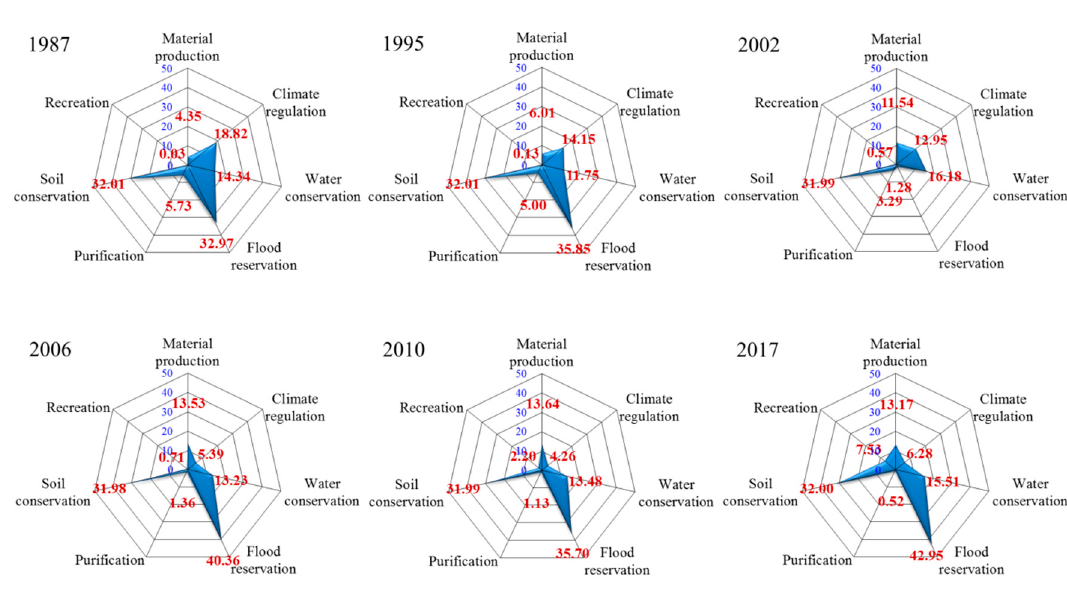
Figure 4. The annual values of each ES from 1987 to 2017 (in red color, 10 million dollars).